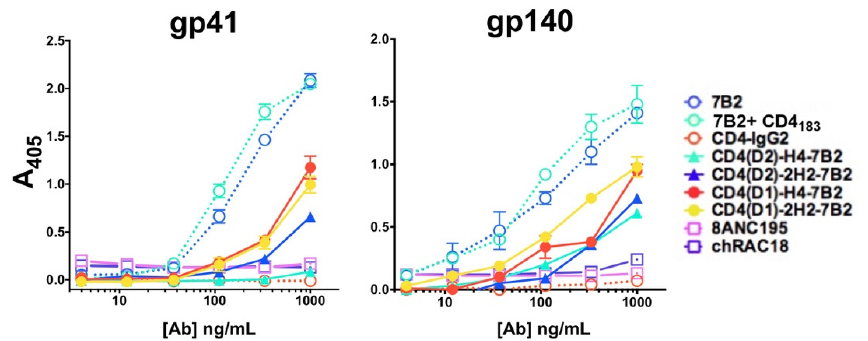
Figure 2. Binding of Abs and Ig-adhesins to envelope antigens by ELISA. We evaluated the binding of a panel of anti-Env mAbs and Ig-adhesins to either a peptide representing the gp41 epitope of 7B2 or trimeric gp140. The novel Ig-adhesins are represented as solid lines and filled symbols, others as dotted lines and open symbols. Binding to the antigen is measured as A 405 , shown as the mean and SEM of triplicate samples. The results shown here are representative of >5 independent experiments.